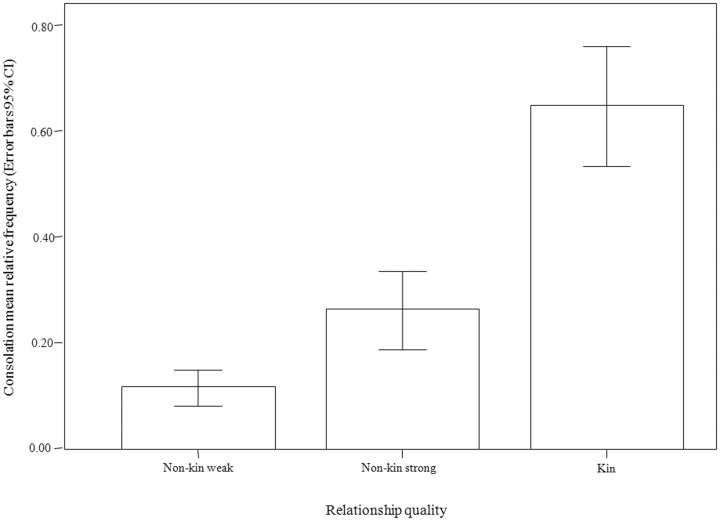
Consolation frequency and relationship quality.Bar graphs of consolation frequency (number of spontaneous third party affiliation events normalized on the number of opportunities, which equaled the number of PCs in which one individual was the recipient, excluding those in which the third-party was involved in the conflict) for bonobo dyads falling into three relationship quality categories: Non-kin weak; Non-kin strong; Kin (with r≥0.25).